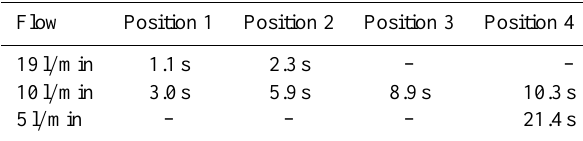
Table 1. Residence time in ZINC before the frozen fraction was detected in dependence of position of detection and total